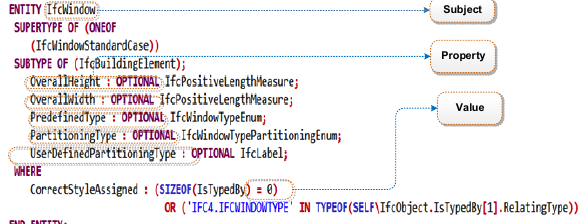
Figure 8. EXPRESS Class representation of IfcWindow ENTITY parameters and corresponding OWL components.